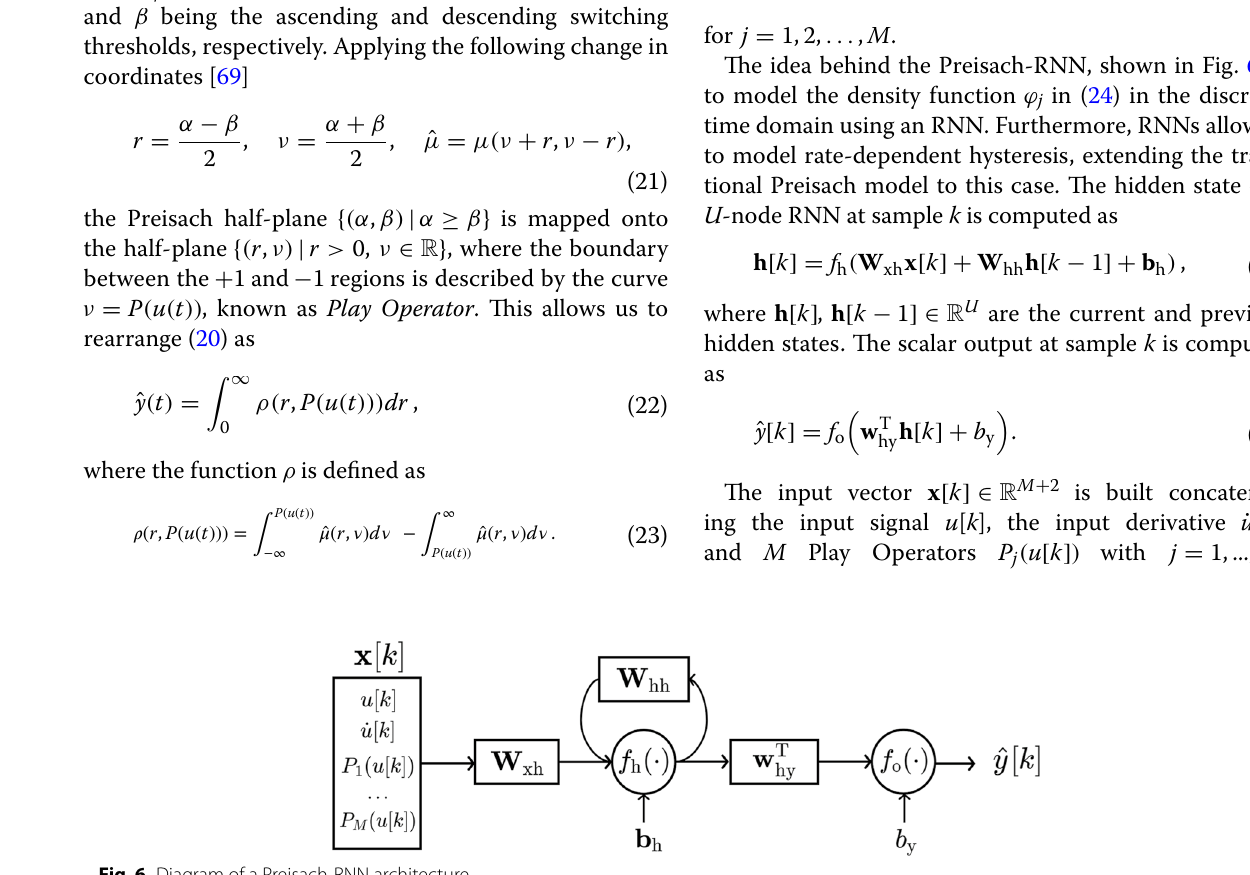
Fig. 6 Diagram of a Preisach-RNN